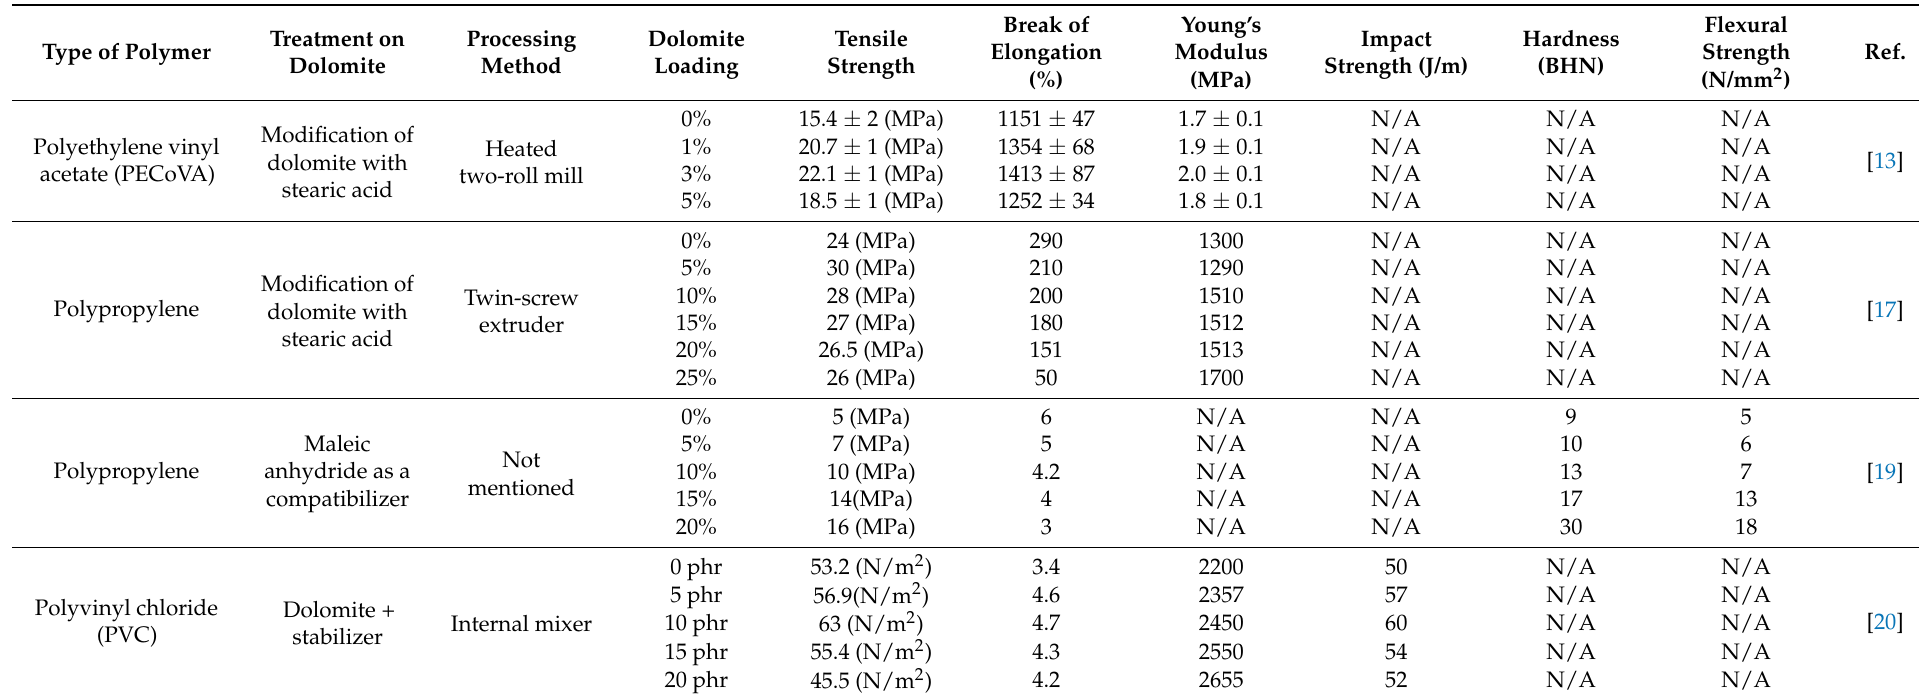
Table 5. Summary of literature studies reporting the different methods used to chemically modify dolomite and the impact on the properties of the polymer/dolomite